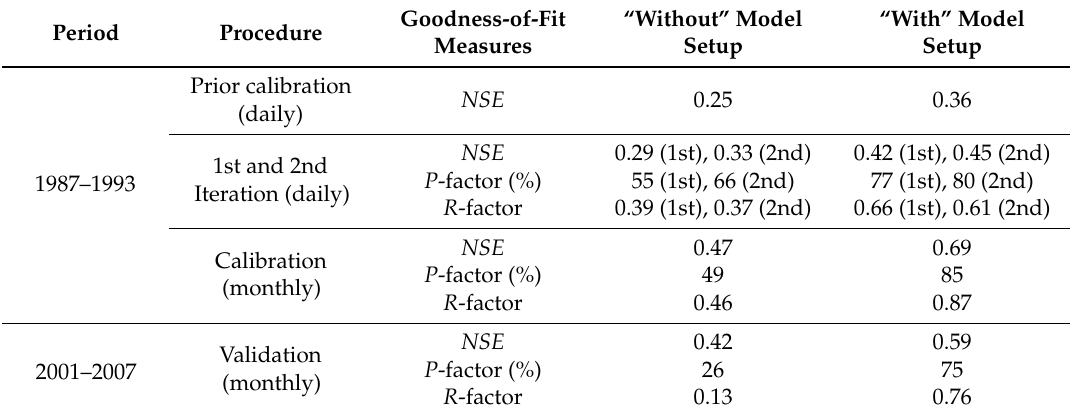
Table 4. Model performances of daily and monthly streamflows with and without elevation bands.